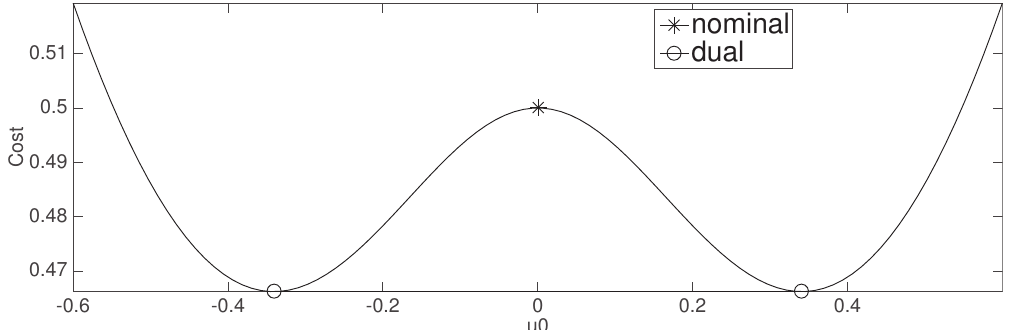
Figure 3. Comparison of the nominal and optimal experimental design on the proposed example for ˆ p 0 = 0. The displayed cost is calculated according to the cost proposed in (24), which reads as experimental design approach has two solutions, due to the non-convexity of the